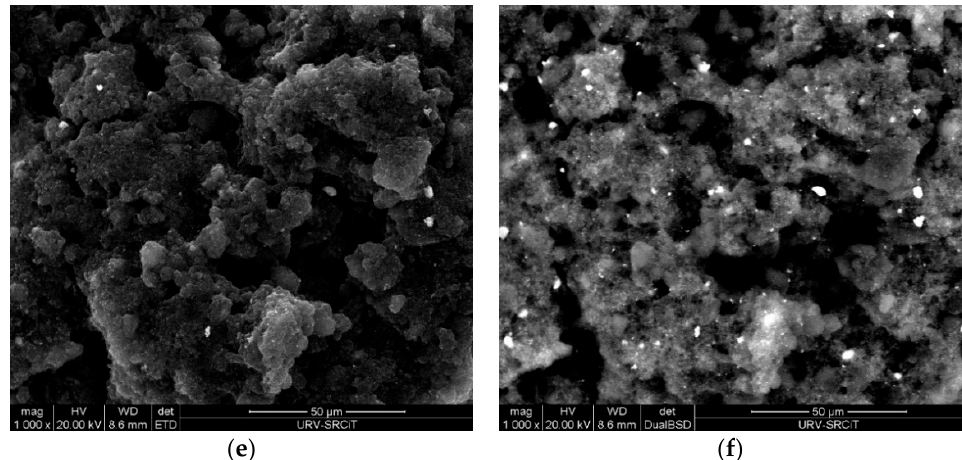
Figure 3. Environmental Scanning Electron Microscope (ESEM) images showing the sensor surface composed by ( a ) bare graphene (5 µ m scale), ( b ) bare graphene (1 µ m scale), ( c ) graphene decorated with tungsten oxide (WO 3 ), ( d ) graphene decorated with WO 3 recorded with back-scattered electron (BSE) detector, showing the graphene (black background) decorated with WO 3 (bright spots). ( e ) Graphene decorated with tin oxide (SnO 2 ), ( f ) graphene decorated with SnO 2 recorded with back-scattered electron (BSE) detector, showing the graphene (black background) decorated with SnO 2 .